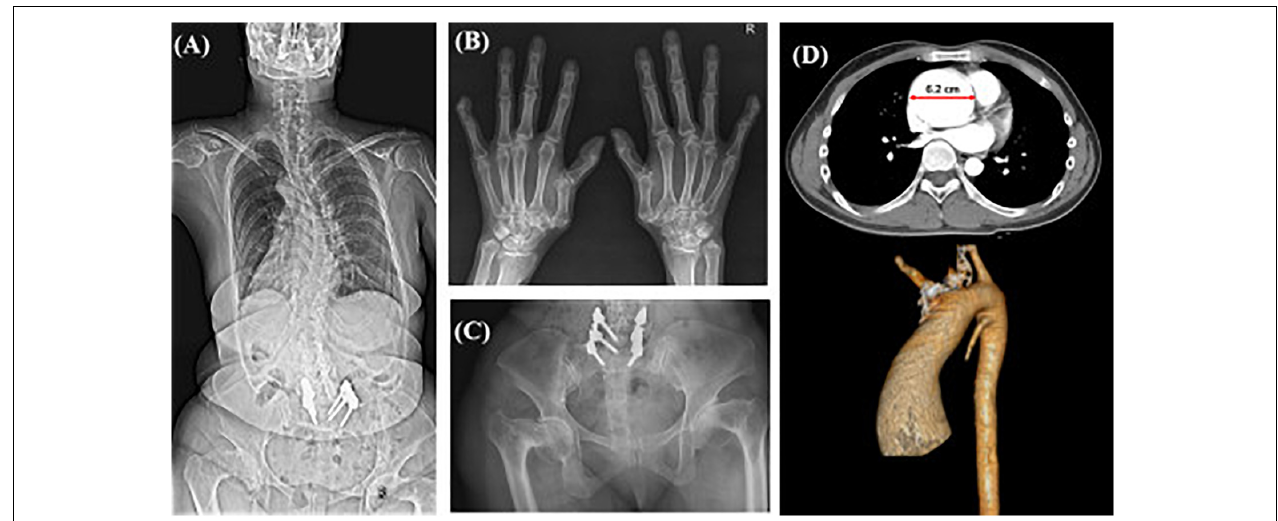
FIGURE 2 | Radiographic images of case #13 and affected mother with aneurysms-osteoarthritis syndrome. X-ray images of the patient’s affected mother showing (A) severe scoliosis despite surgical correction, (B) degenerative osteoarthritis of the hand joints with subluxation of the 1st carpometacarpal joints, (C) bilateral severe coxa vara deformities; (D) CT scan with 3D reconstruction of Case #13 showing aneurysm of the ascending aorta with a dilated root (diameter: 6.2 cm).